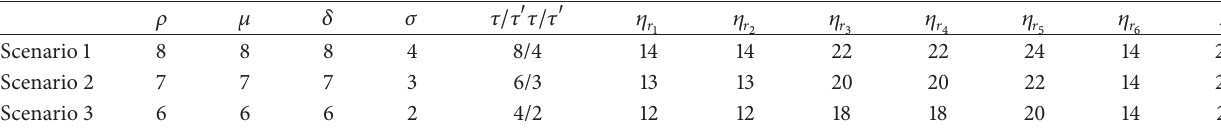
Table 5: Bits length of parameters in our experiments.